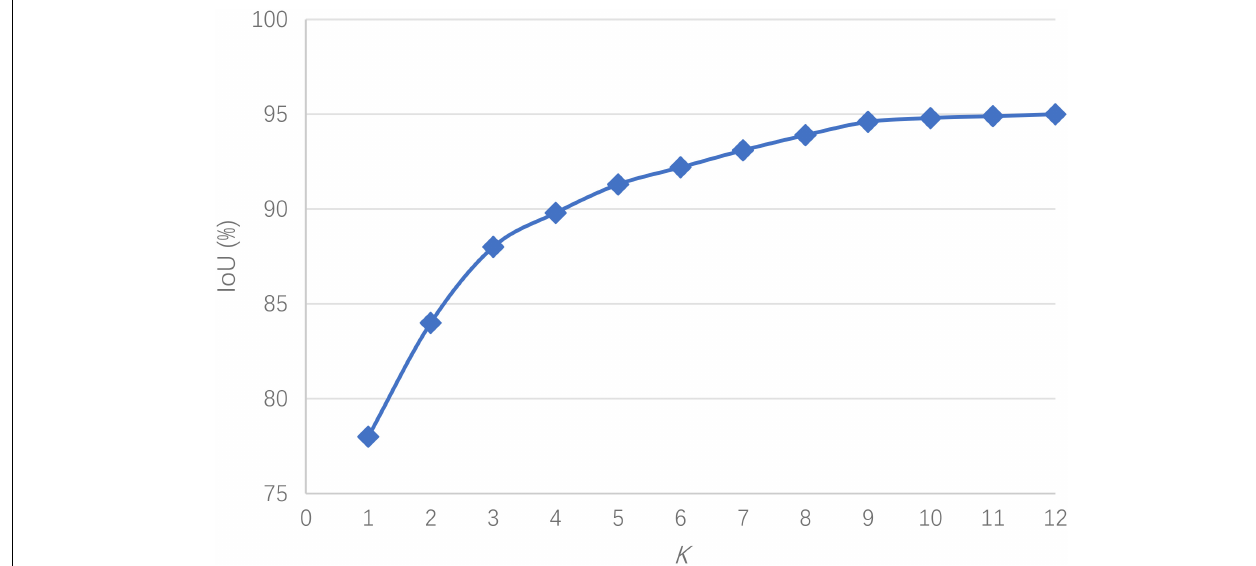
FIGURE 6 | The relationship between the IoU and K.